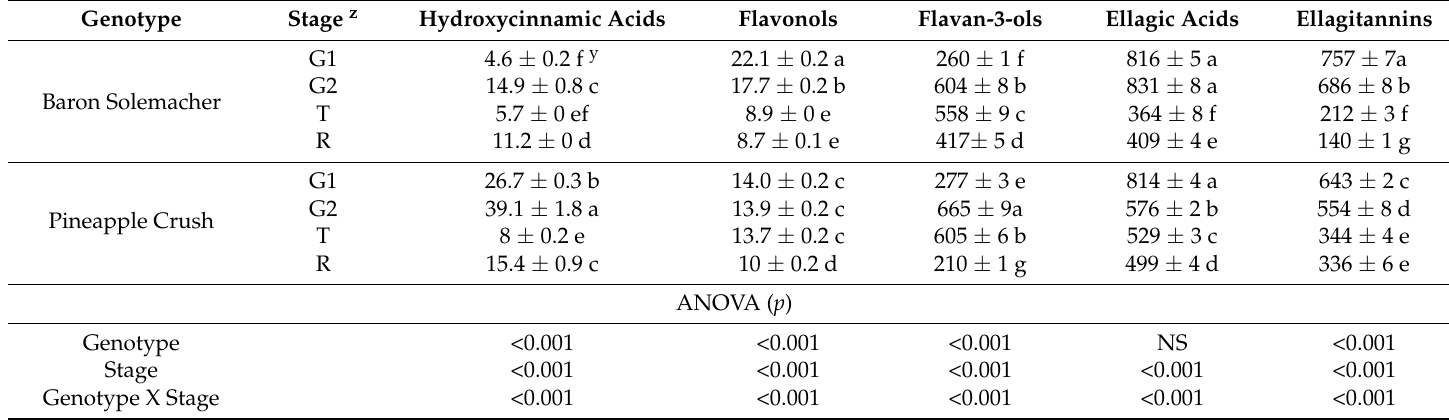
Table 3. Total content (mg/100 g fruit fresh weight) of major classes of phenylpropanoids/flavonoids based on a subset of target compounds from each class from the Fragaria vesca red-fruited cultivar ‘Baron Solemacher versus the white-fruited cultivar Pineapple Crush at four stages of fruit